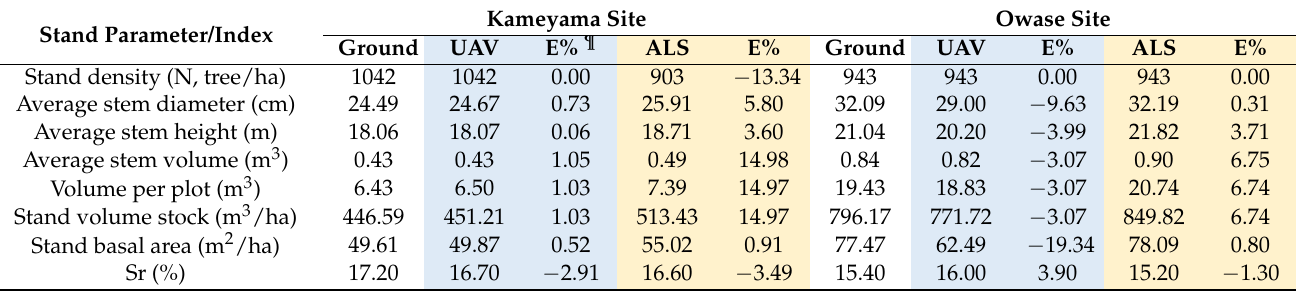
Table 8. Summary of stand-level parameters derived from UAV-SfM-CHM and ALS-CHM